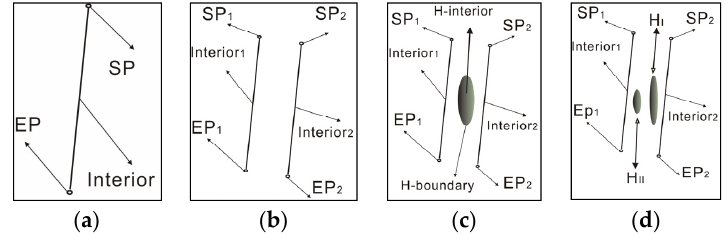
Figure 4. Simple GIS river planform models. ( a ) Single straight line model (SSLM); ( b ) double straight line model (DSLM); ( c ) double straight line one-region model (DSL-1RM); ( d ) double straight line several-regions model (DSL-SRM).